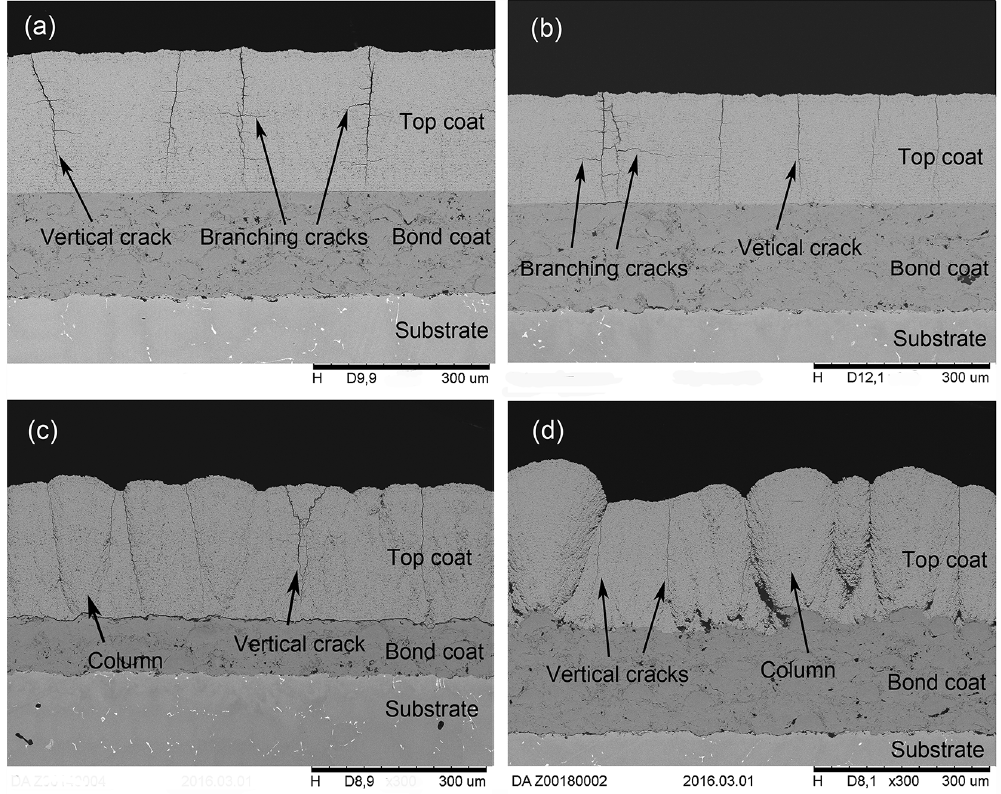
Figure 1. Cross-section SEM image of as sprayed YSZ top coats (Samples A, B, C, and D) deposited at a standoff distance of 70 mm, on BC with different surface treatments: ( a ) mirror polishing; ( b ) grinding; ( c ) grit blasting; and ( d ) as ‐ sprayed.